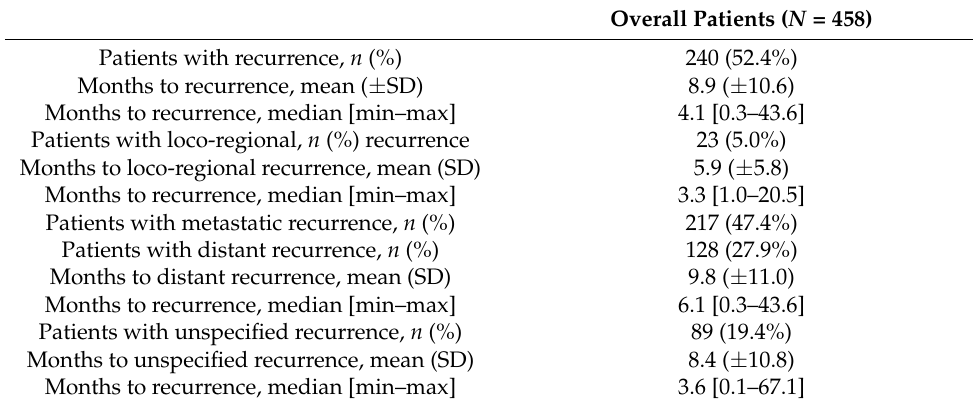
Table 2. Recurrence and time to recurrence in eNSCLC patients with chemotherapy after surgery in stage II–IIIA (study period January 2015–June 2021).